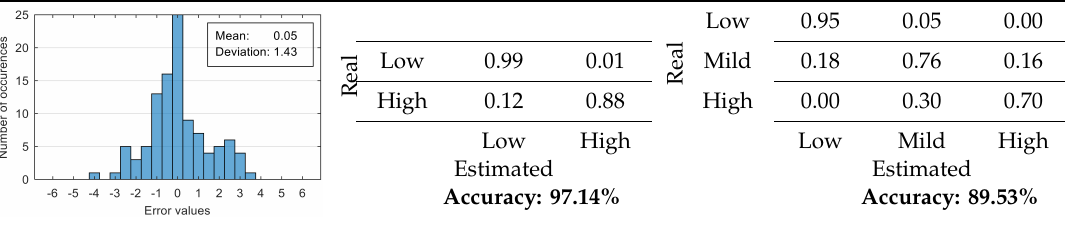
Table 10. Distribution of estimation errors and confusion matrices for levels 2 and 3—using five features.